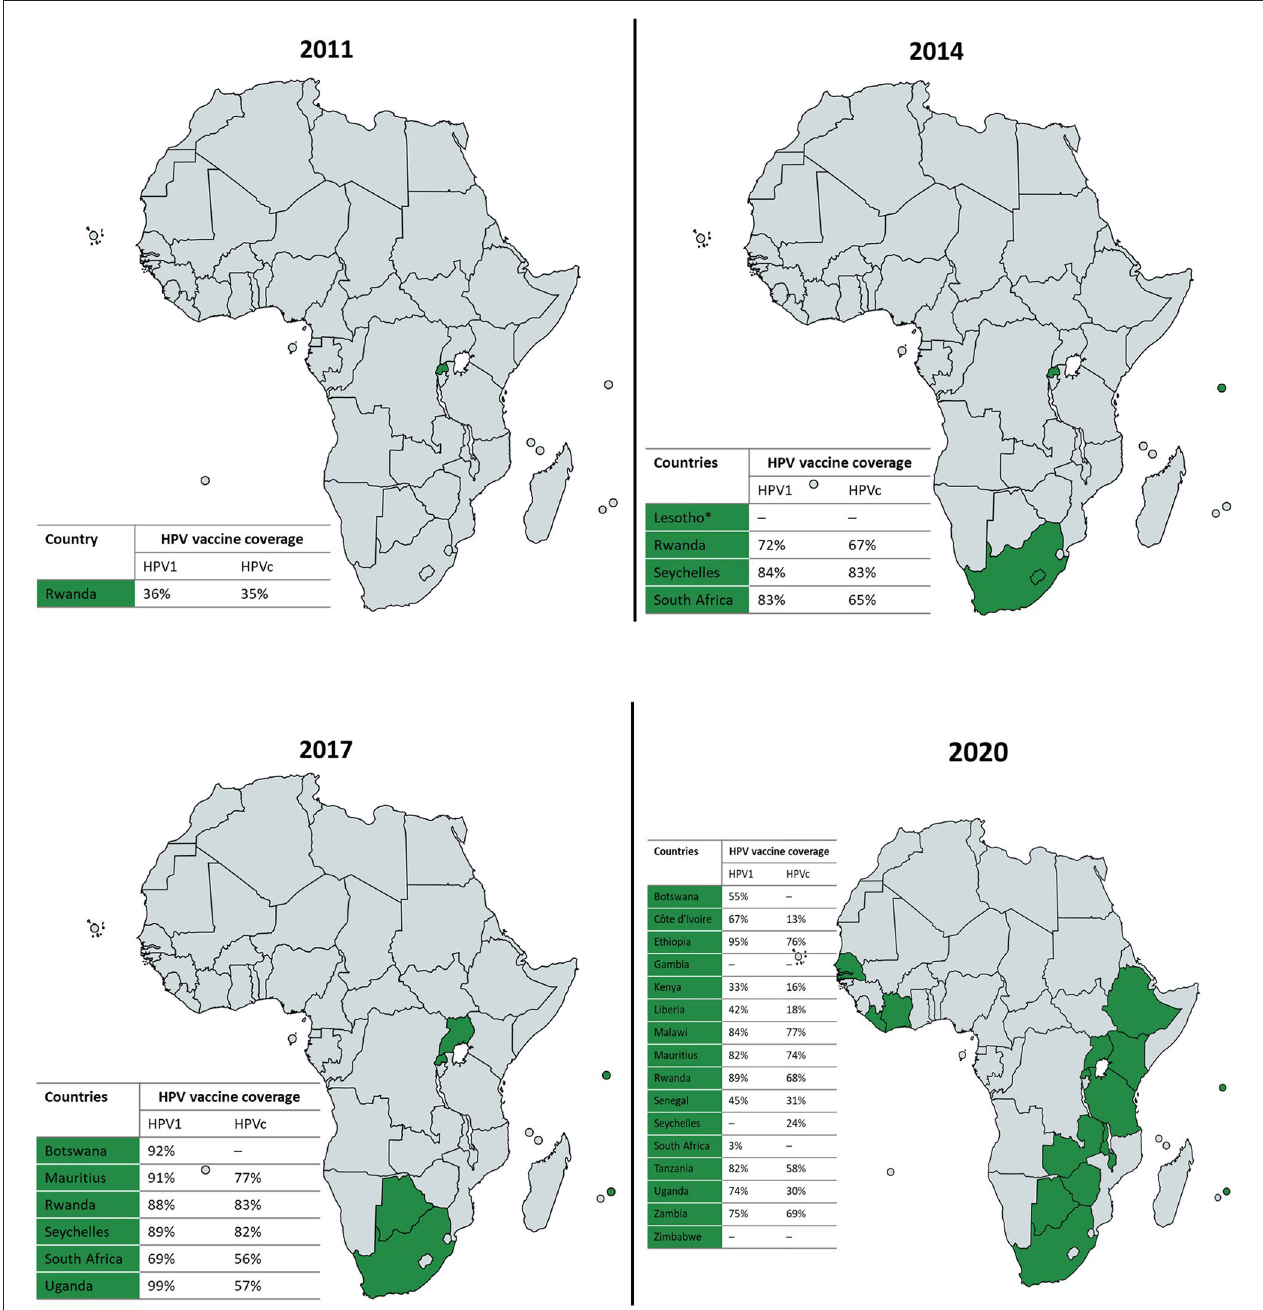
FIGURE 1 | Progress of nationwide HPV vaccine introduction and coverage in sub-Saharan Africa, 2011–2020 (16, 17). Where available, national HPV vaccine coverage data for the first (HPV1) and last (HPVc) doses per each reporting year is presented in the accompanying tables. *Lesotho implemented nationwide HPV vaccination in 2012 but stopped in 2015; and is projected to have the HPV vaccine back on the national routine immunization schedule by 2022. Maps created in